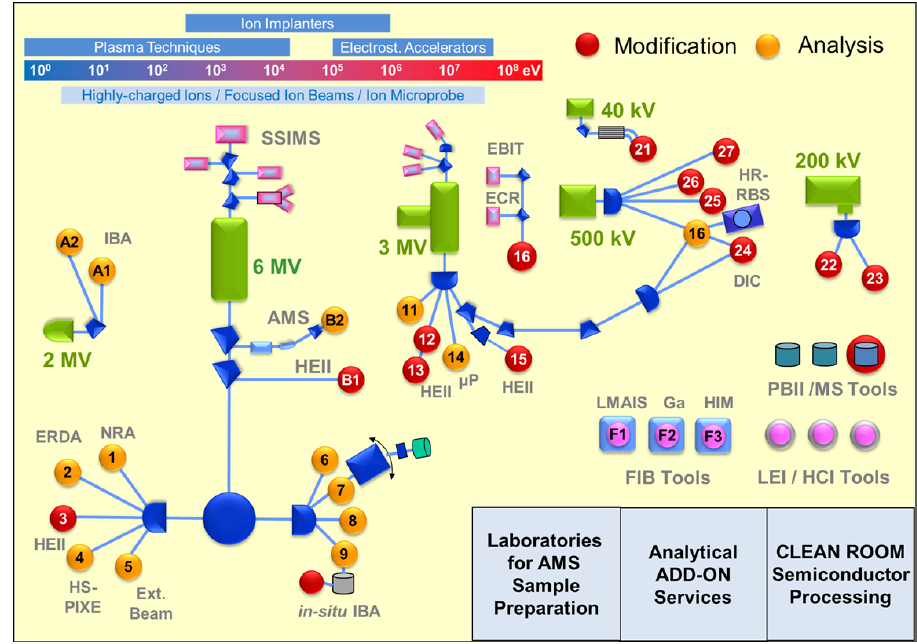
Figure 1: Layout of the Ion Beam Center, the color code illustrates various classes of tools / end-stations with respect to different user experiments. Further information and end-station descriptions are given at the IBC homepage